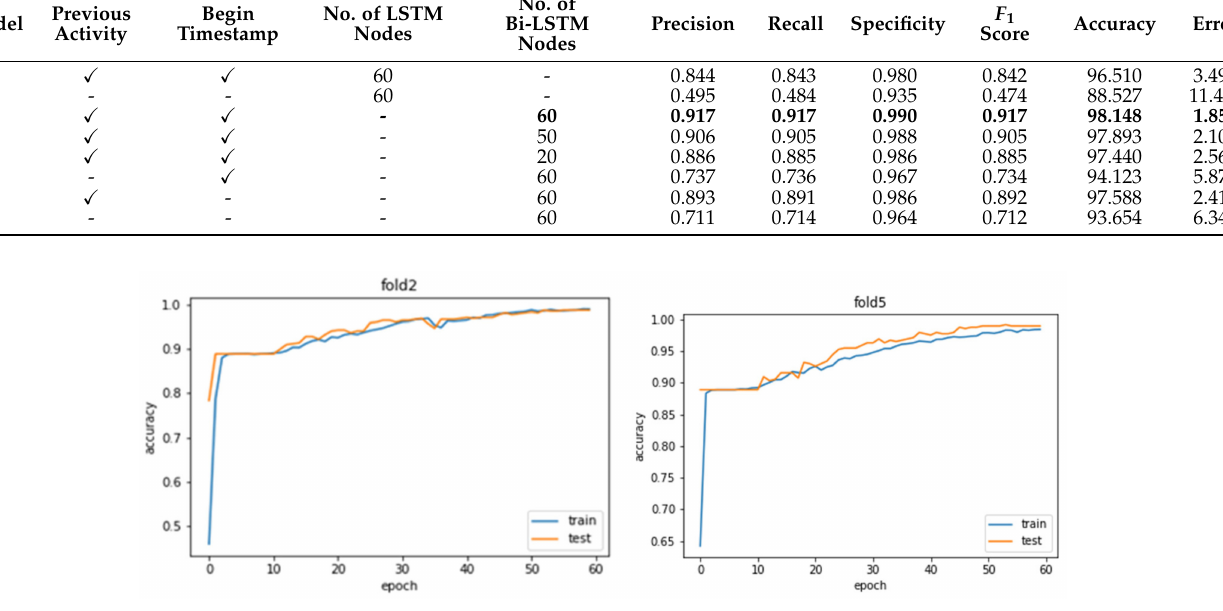
Table 7. Comparison Results of Proposed Model with Different Combinations of Modules. Model